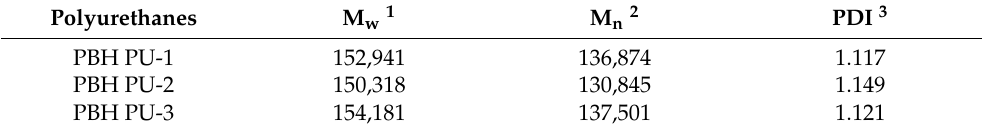
Table 3. GPC data of polyurethane series.